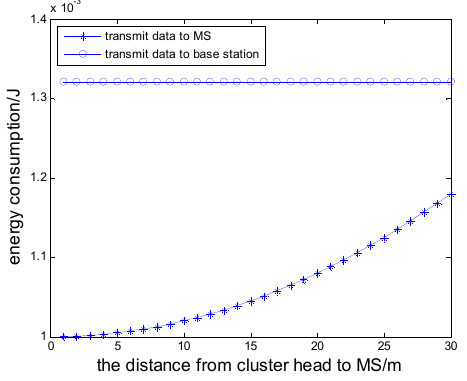
Figure 8. The contrast of energy consumption for transmitting data to the base station and the MS.